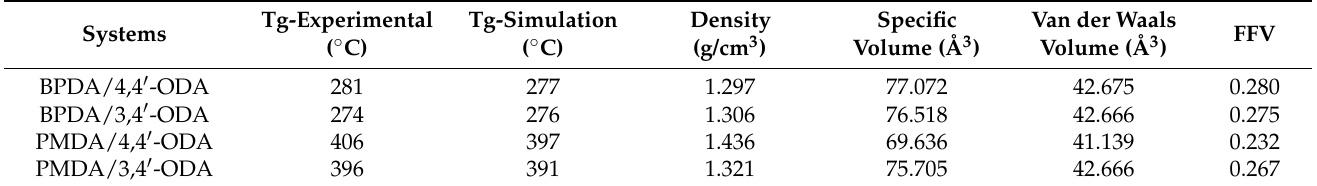
Table 2. Tgs, density, specific volume, Van der Waals volume, and FFV of different systems of PIs. Systems